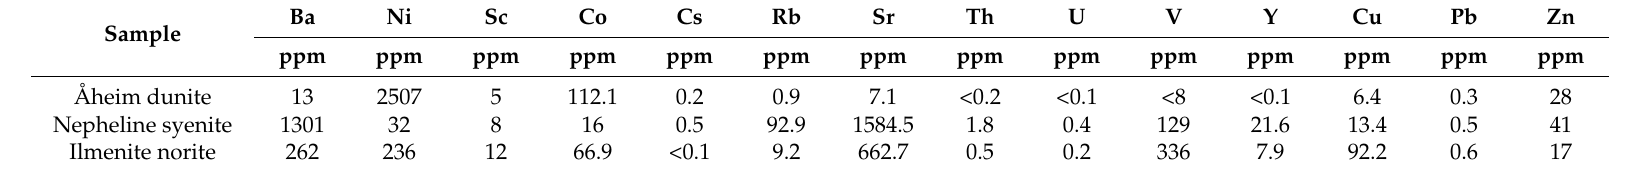
Table 2. Trace element contents of the silicate powders in parts per million (ppm).